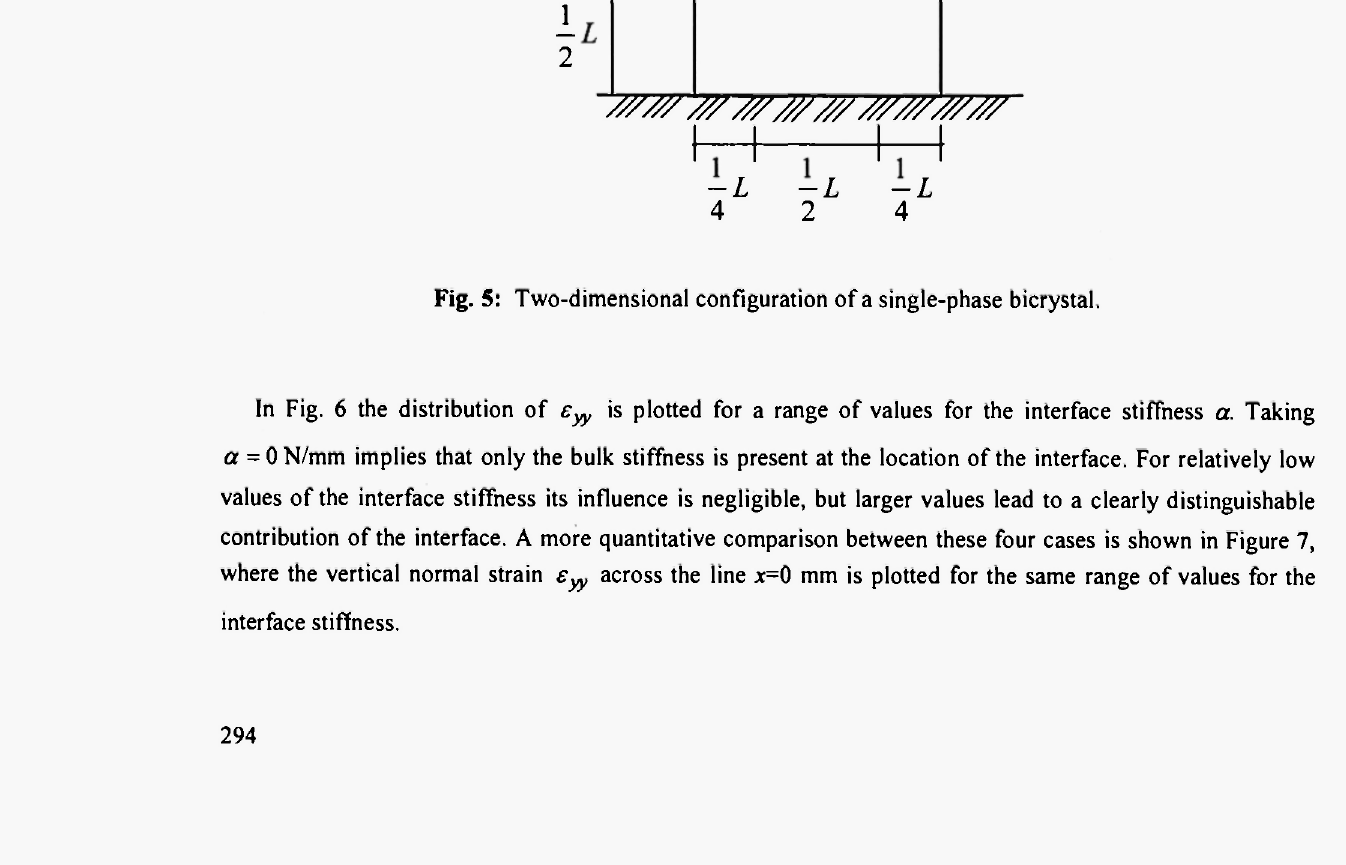
Fig. 5: Two-dimensional configuration of a single-phase